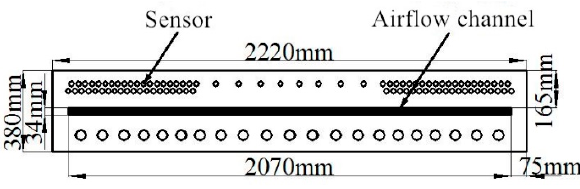
Figure 1. A schematic diagram of the SI-FLAT flatness meter measurement platform.